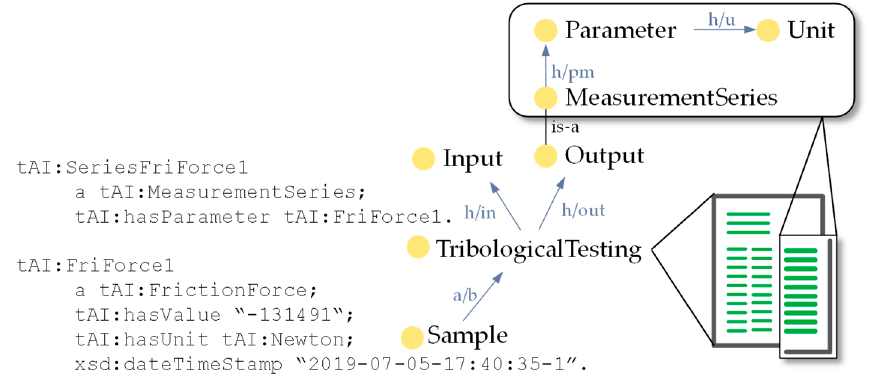
Figure 7. Modeling measurement series as output from tribological testing.